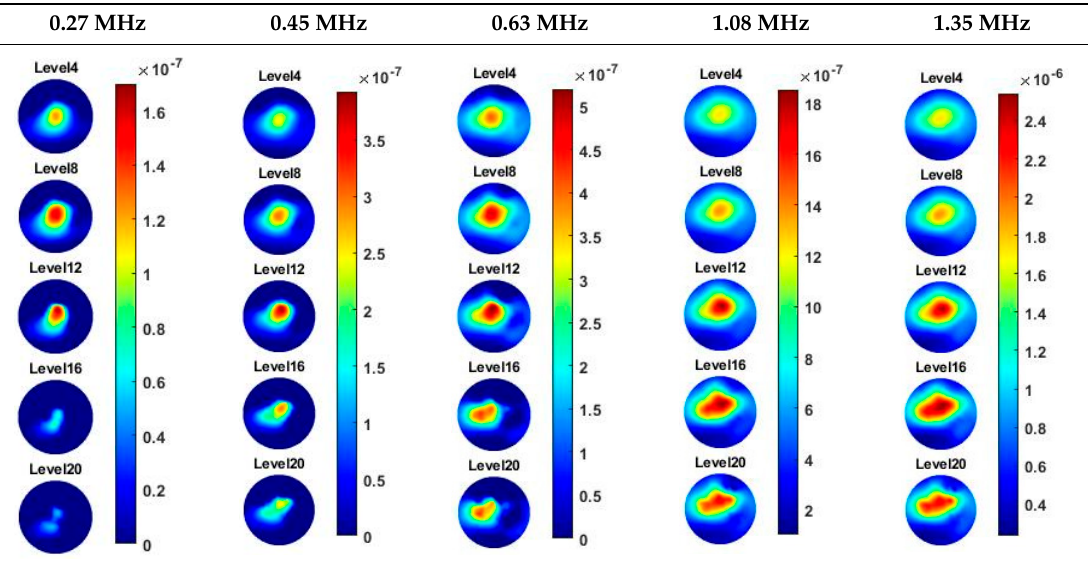
Figure 13. ( a ) Experiment scenario for garlic sample. ( b ) Reconstructed 2D images with multifrequency. (Colorbar units: mS/cm) ( c ) Reconstructed conductivity spectra. ( d ) Derivative of the conductivity with respect to the frequency.